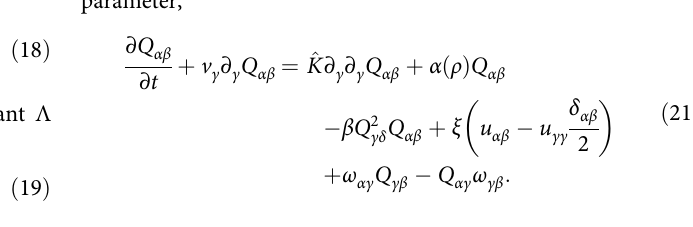
R R q j j d 2 r versus colony size, ρ d 2 r (in R R R r j j d 2 r / d 2 r , where q > 0 q > 0 q > 0